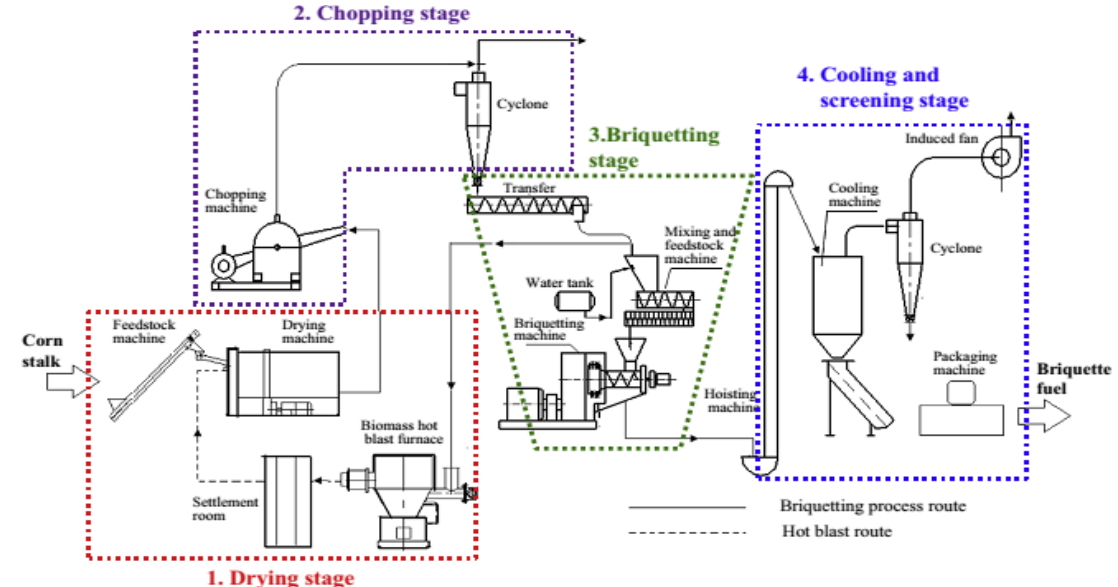
Figure 7. Schematic diagram of the biomass briquette fuel production system